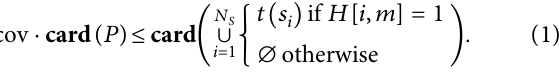
a cuckoo search algorithm fnds the maximum number of